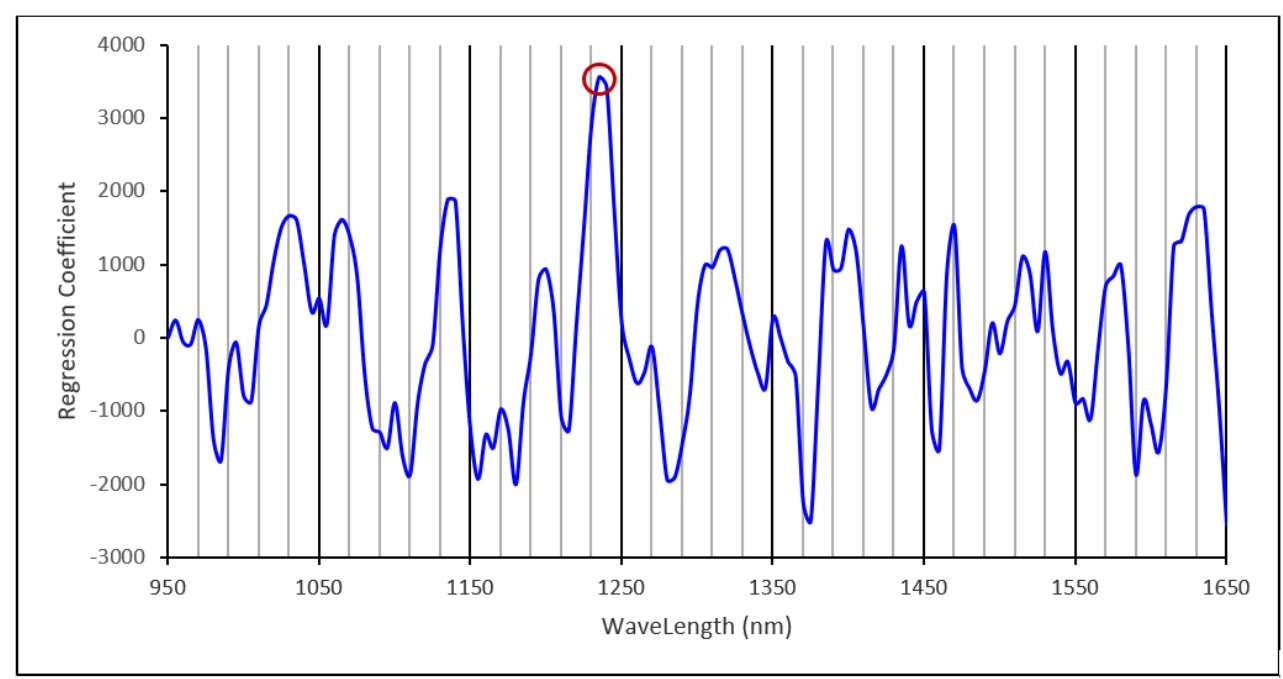
Figure 5. The relationship between laboratory determined and NIR predicted amylose contents for the amylose NIR cali- bration ( left ) and validation ( right ).